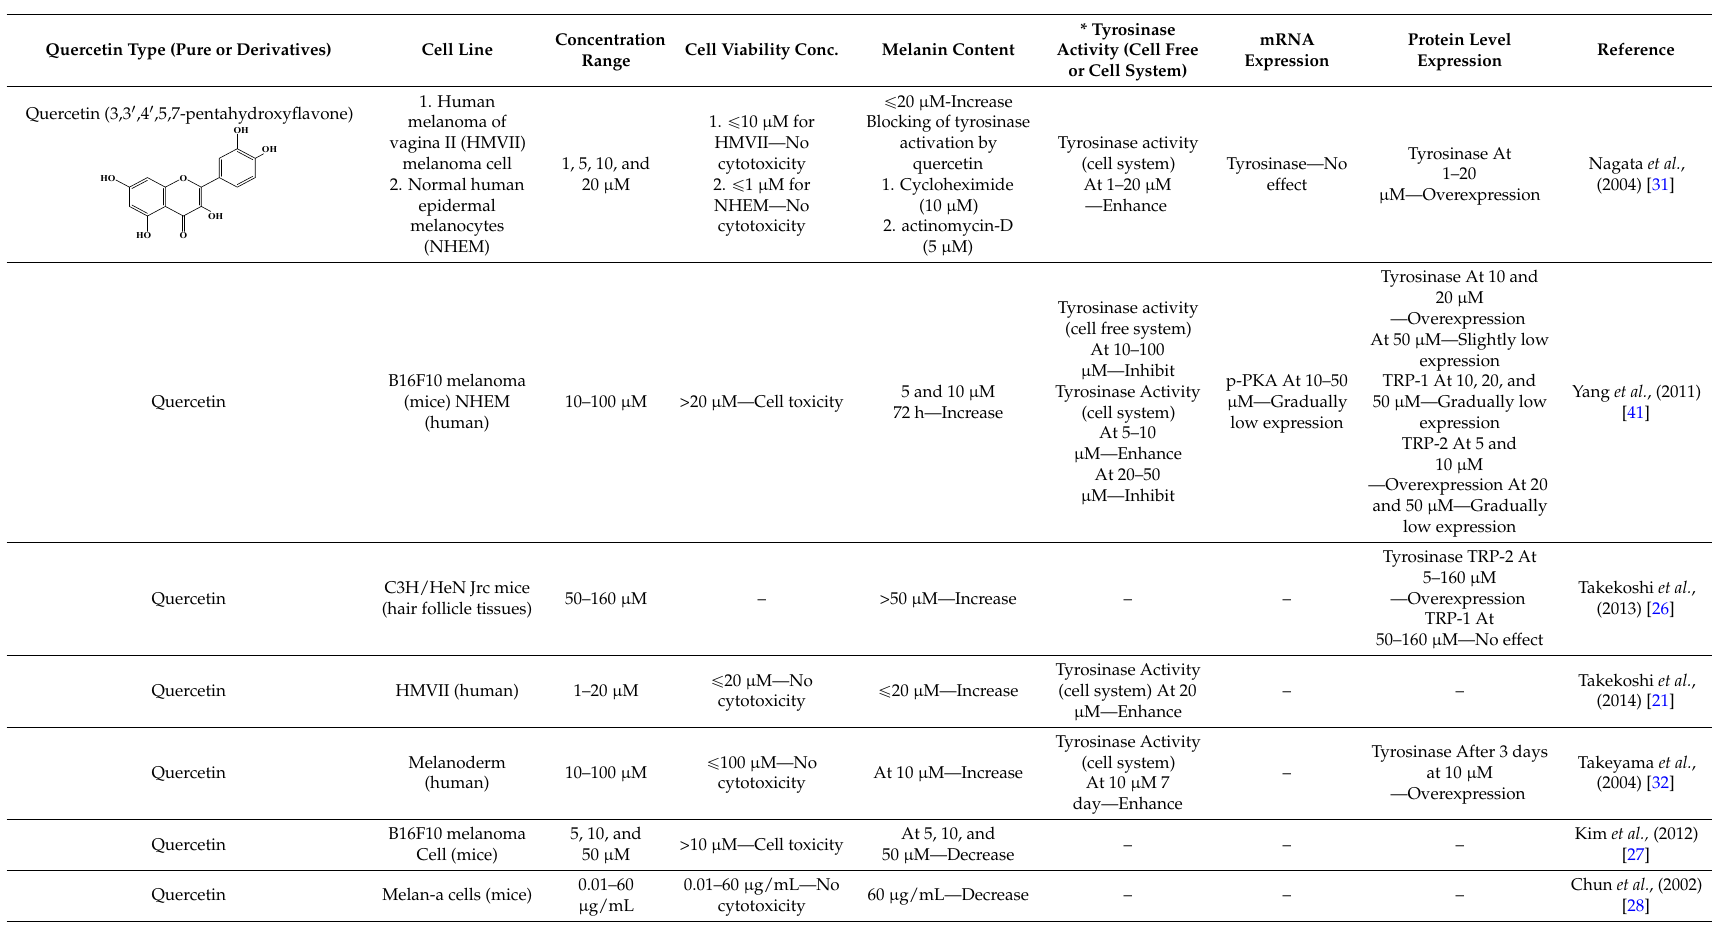
Table 1. Literature summary of in vitro anti-melanogenesis effect by quercetin and its derivatives.